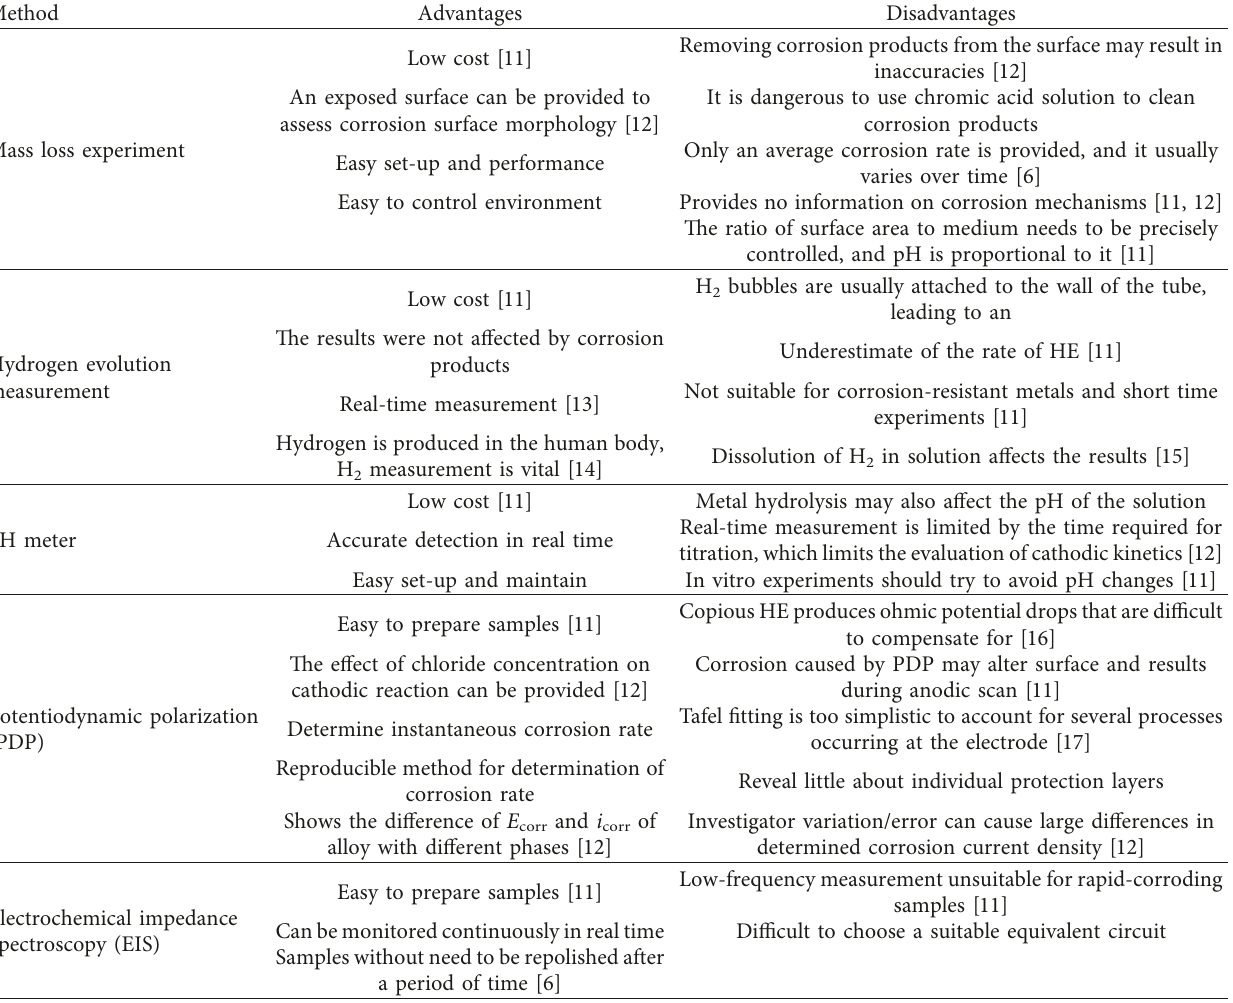
Table 1: Summary of available